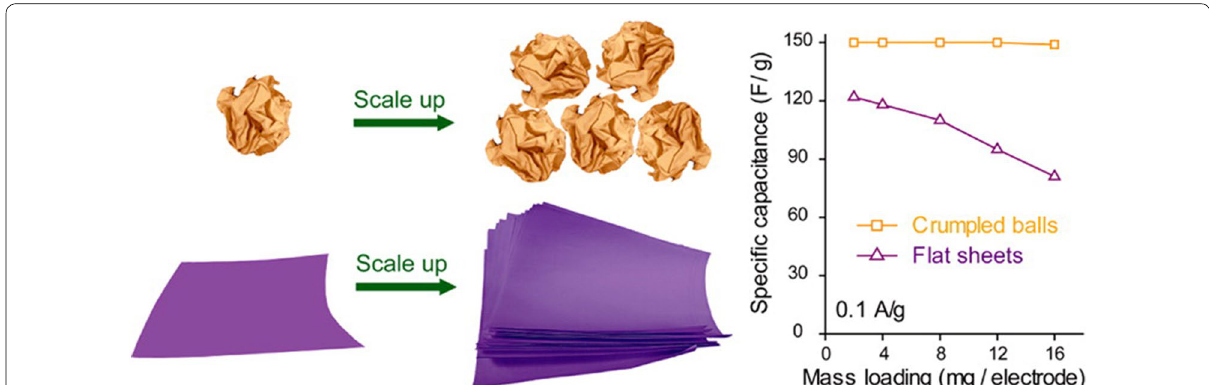
Fig. 5 Schematic illustration of crumpled graphene balls and uncrumpled graphene sheets with their specific capacitances depending on the electrode mass loading (Reprinted with permission